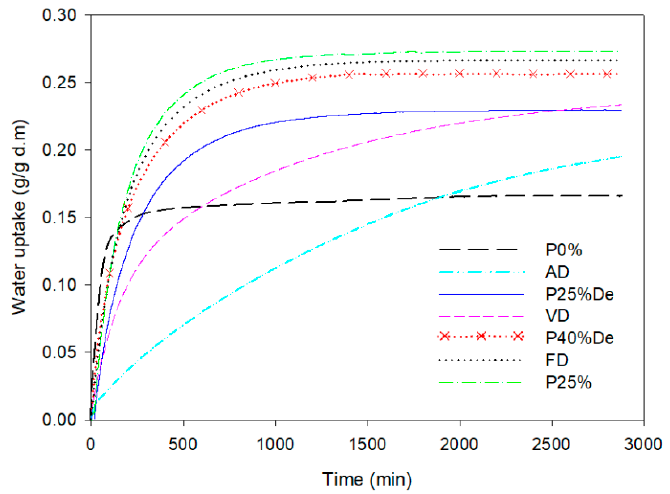
Figure 2. Effect of composition of gels and drying method on the water kinetics uptake of apple puree snacks.